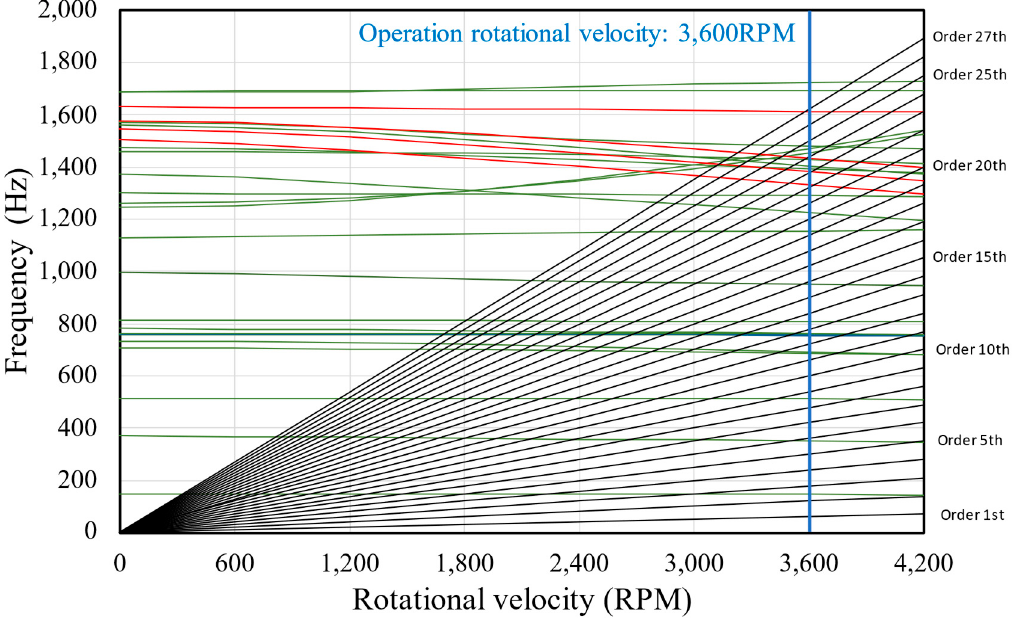
Figure 25. The Campbell diagram of first-stage moving blades.